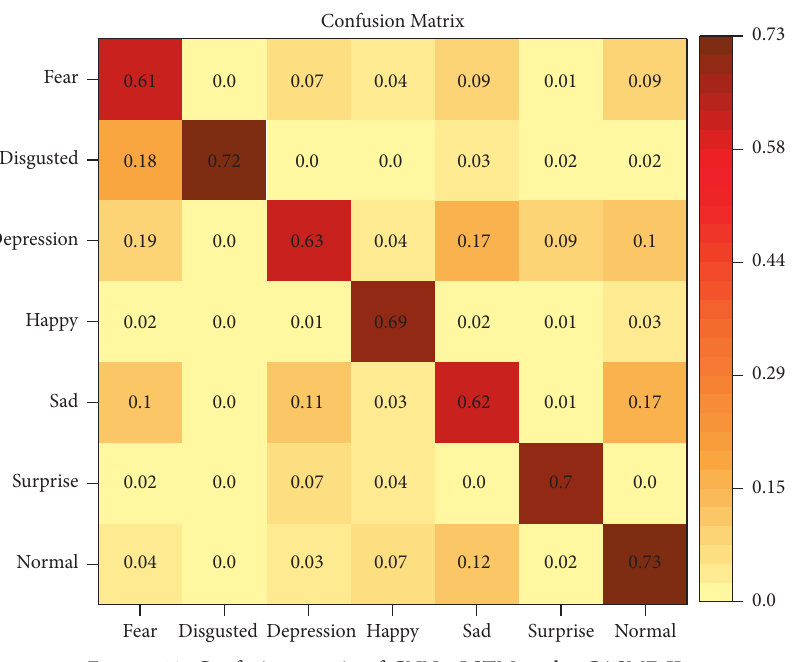
Figure 12: Confusion matrix of CNN +LSTM under CASME II.